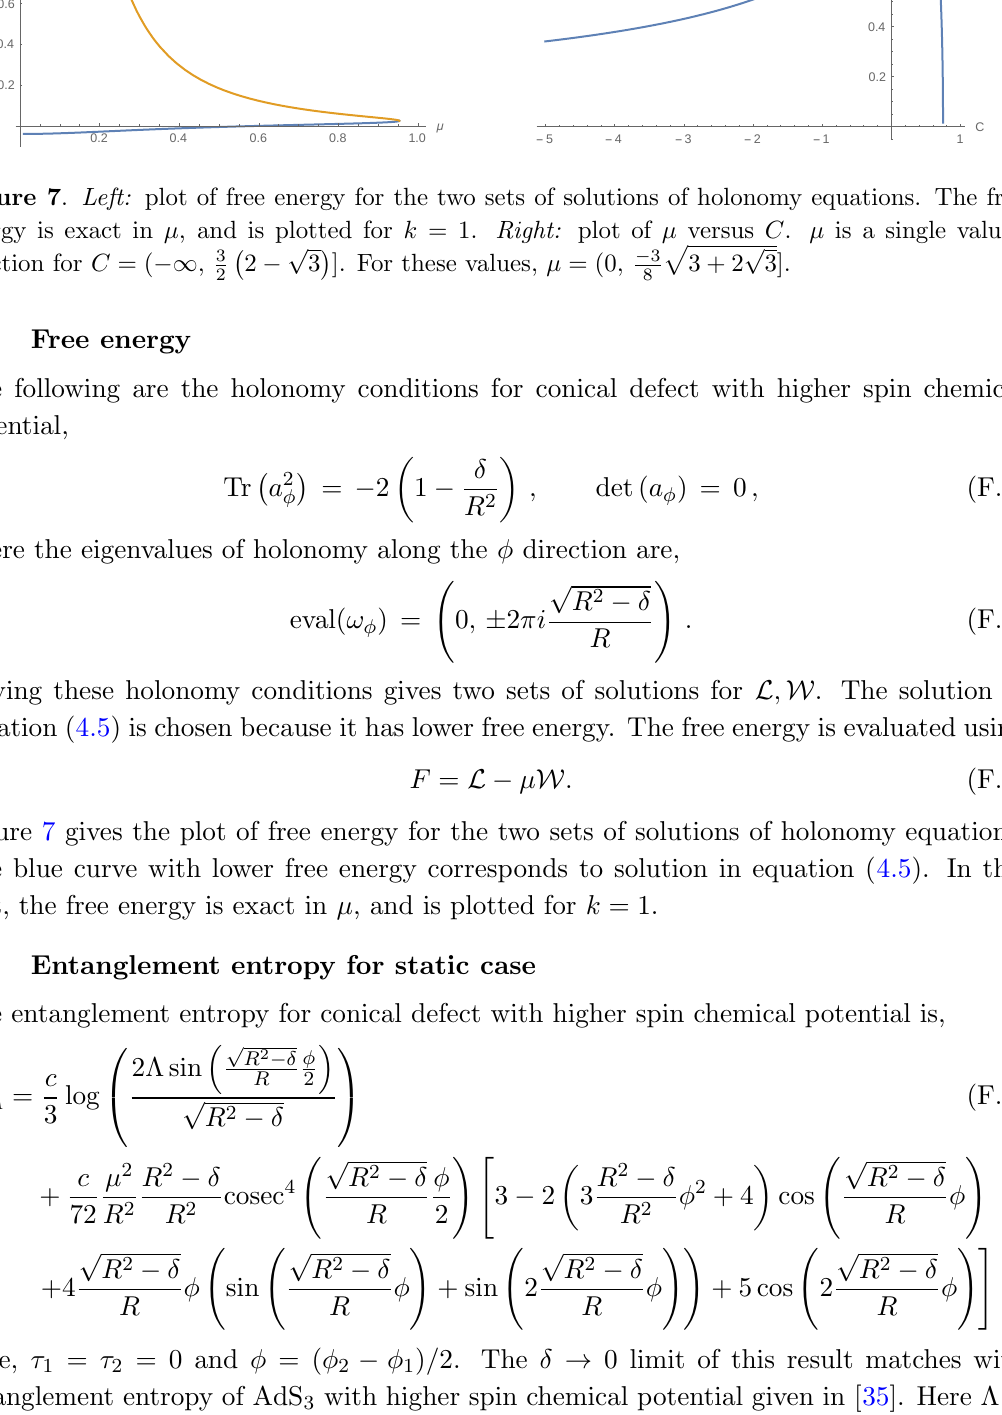
p (cid:0) (cid:1) 2 (cid:0) 3 ]. For these values, (cid:22) = (0 ; (cid:0) 3 2